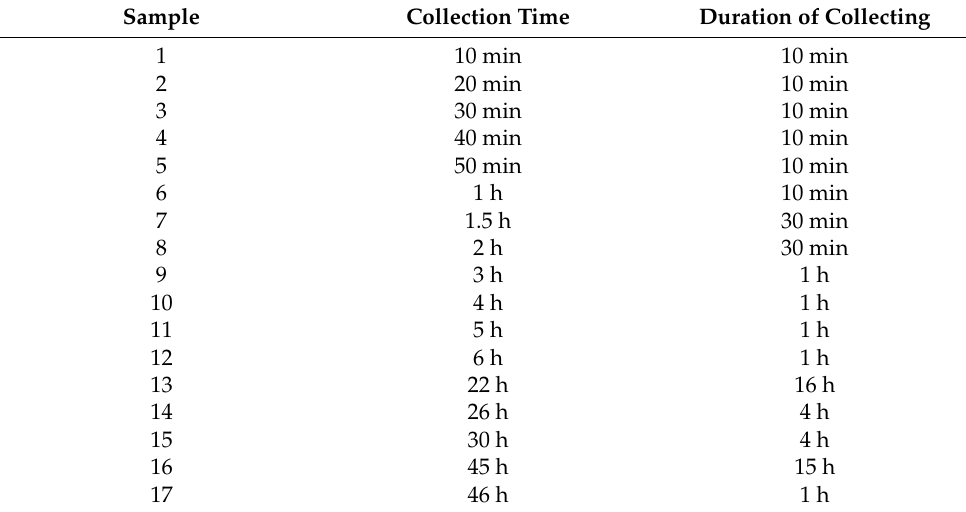
Table 2. Overview of microdialysis collection